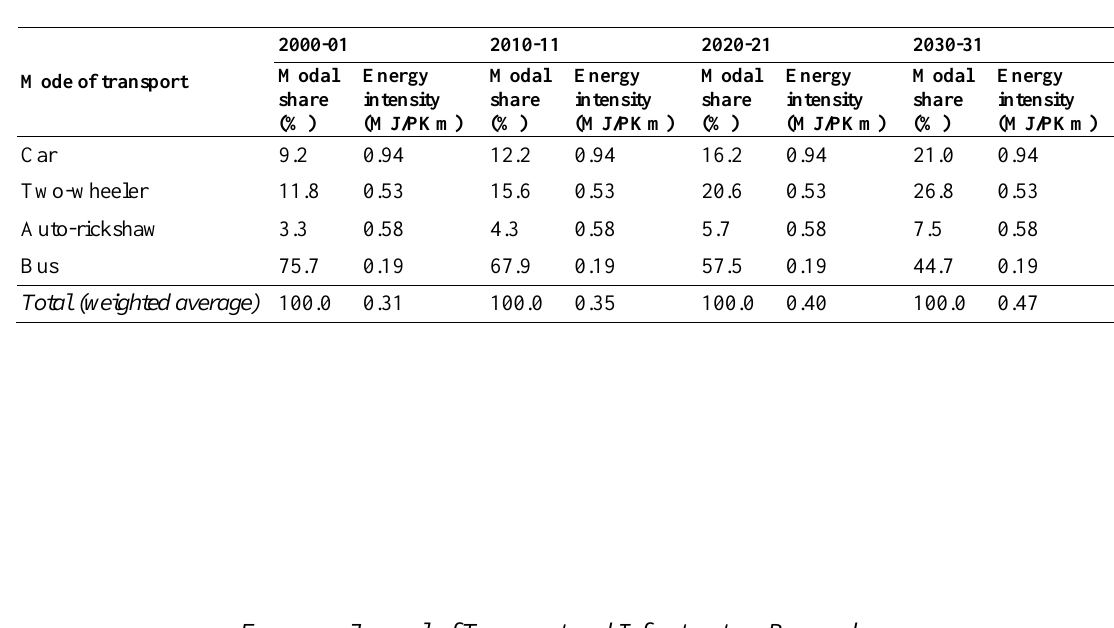
Table 5. Modal share and energy intensities from 2000-01 to 2030-31; business as usual